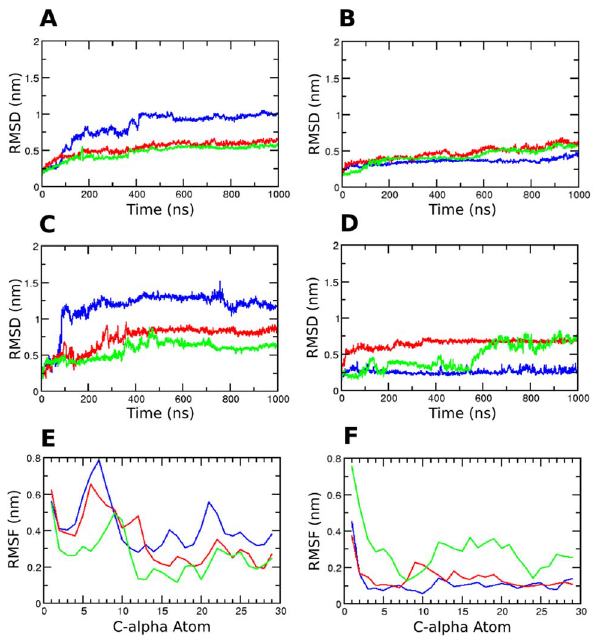
Fig. 2. Structural characterization of the b 2 AR variants. All atom protein RMSD of (A) Arg and (B) Gly variants of b 2AR with respect to the first frame of the production run. All atom RMSD of the N-terminal residues 1 to 29 of (C) Arg and (D) Gly variants of b 2AR. RMSF profile of the N-terminal C-alpha atoms of (E) Arg and (F) Gly variants. For each plot, the blue line indicates the first simulation, the red indicates the second and the green line indicates the third simulation.